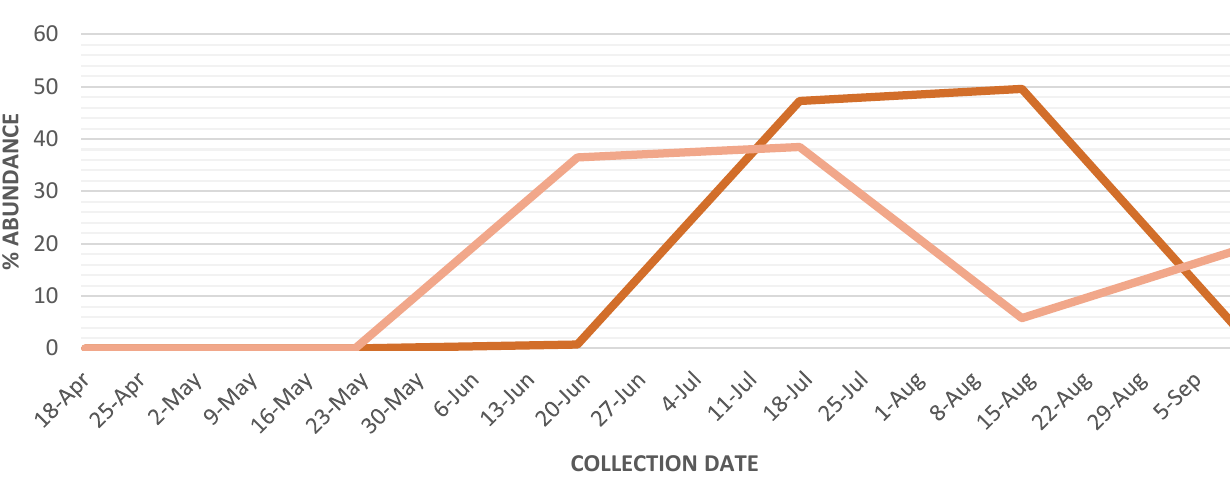
Figure 3. Relative seasonal trap abundance for Psilochalcis minuta over a two-year period at Utah; Juab County, Yuba Valley. Note that peak abundance shifted one month earlier between years.